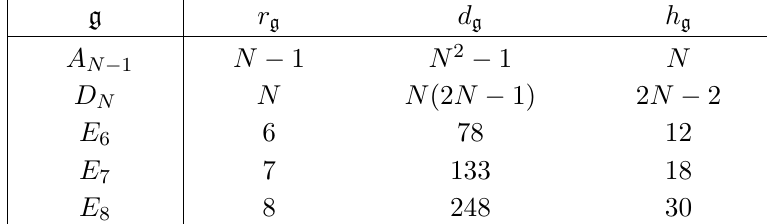
Table 1 . Rank, dimension and Coxeter number for the simply laced Lie